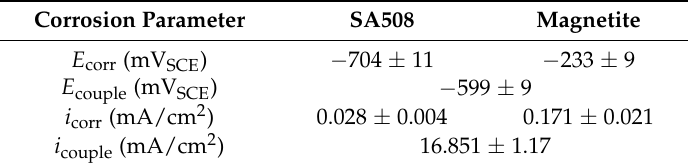
Figure 5. Polarization curves of SA508 and magnetite electrodes in 10% EDTA-based chemical cleaning solution at 93 °C. Table 2. Electrochemical corrosion parameters of SA508 and magnetite in 10% EDTA solution at 93 °C.